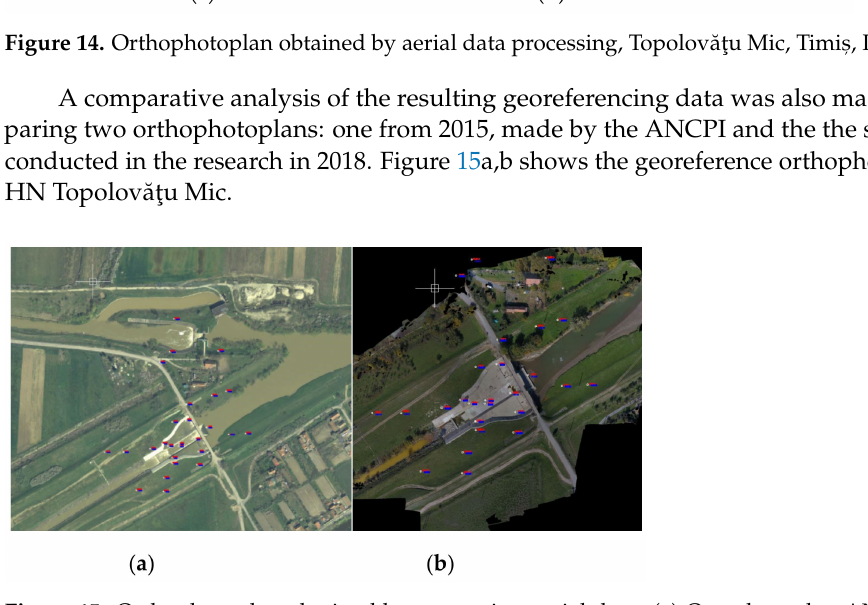
Figure 15. Orthophotoplan obtained by processing aerial data: ( a ) Ortophotoplan ANCPI—2015 (Topolov ă ¸tu Mic, Timis , Romania); ( b ) Ortopotoplan UAV—2018 (Topolov ă ¸tu Mic Hydrotechnical , Node, Timis , ,